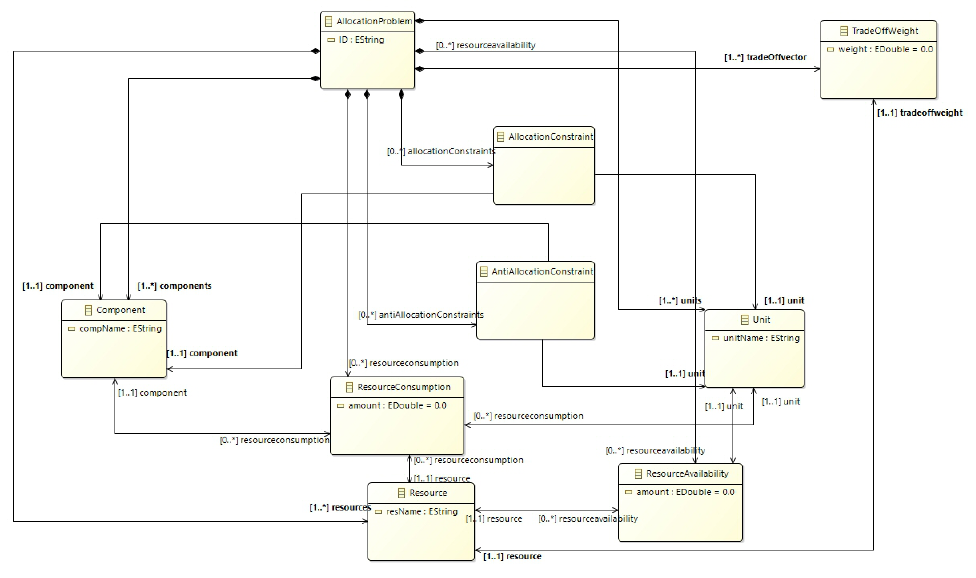
Figure 4. The CAP meta-model.